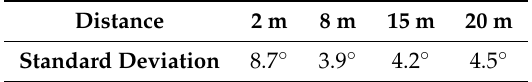
Table 1. Standard deviation when user stands close to a